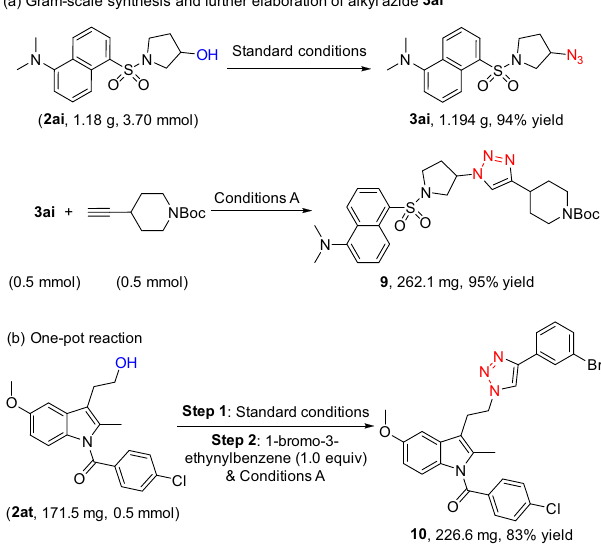
Fig. 4 Mechanistic experiments. a The comparison of the standard experiment and the control experiments. Eq 1 refers to the deoxyazidation reaction conducted under the standard conditions. Eq 2 refers to the control experiment performed in the absence of DBU. Eq 3 refers to the control experiment performed via reverse addition of the reactants. b Proposed mechanism of competitive consumption of SulfoxFluor by NaN 3 (Eq 4) and the desired deoxyazidation of alcohols (Eq 5). ND not